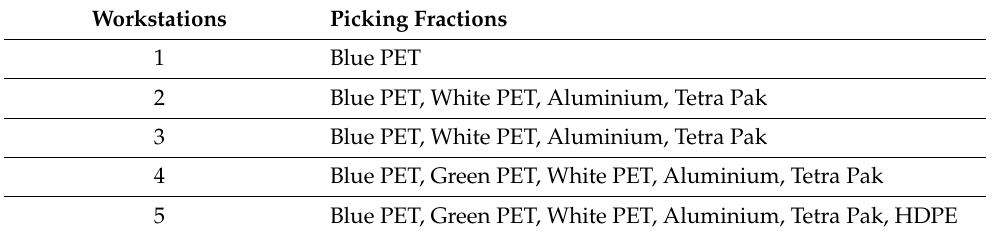
Table 2. Types of waste sorting on individual workstations.